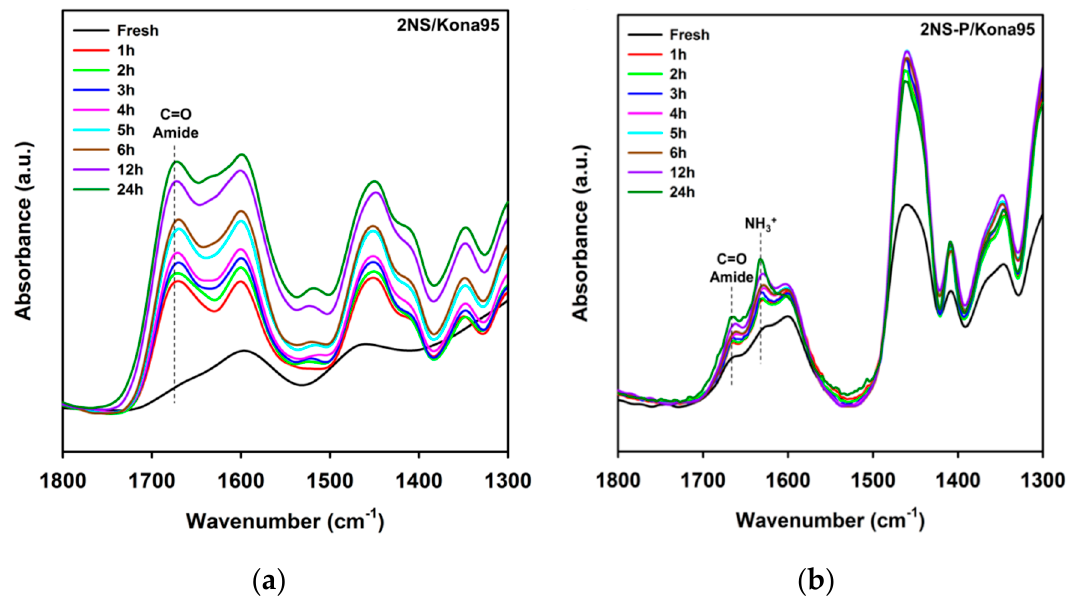
Figure 6. Changes in the in situ FT-IR spectra of ( a ) 2NS/Kona95 and ( b ) 2NS-P/Kona95 exposed to 21% O 2 /balance N 2 at 110 °C.